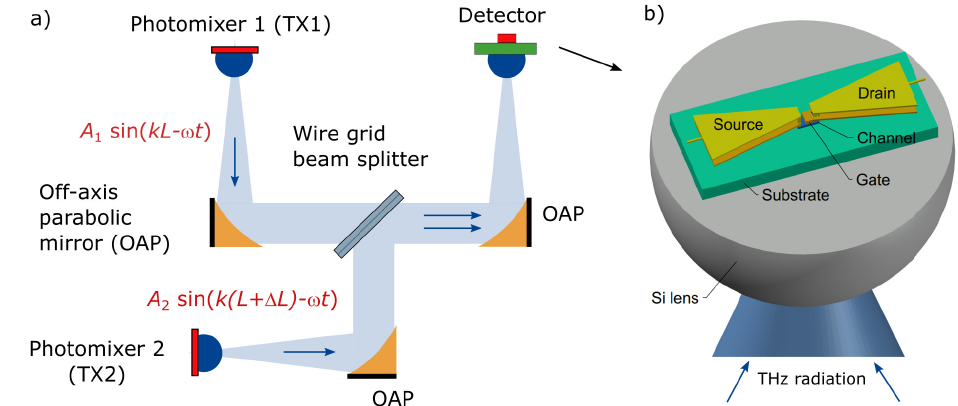
Figure 1. ( a ) The THz homodyne measurements’ optical setup. ( b ) Simplified schematic image of the THz detector. The dimensions of the antenna metallization (yellow) and of the Si lens (grey) are not to scale in order to demonstrate the device structure